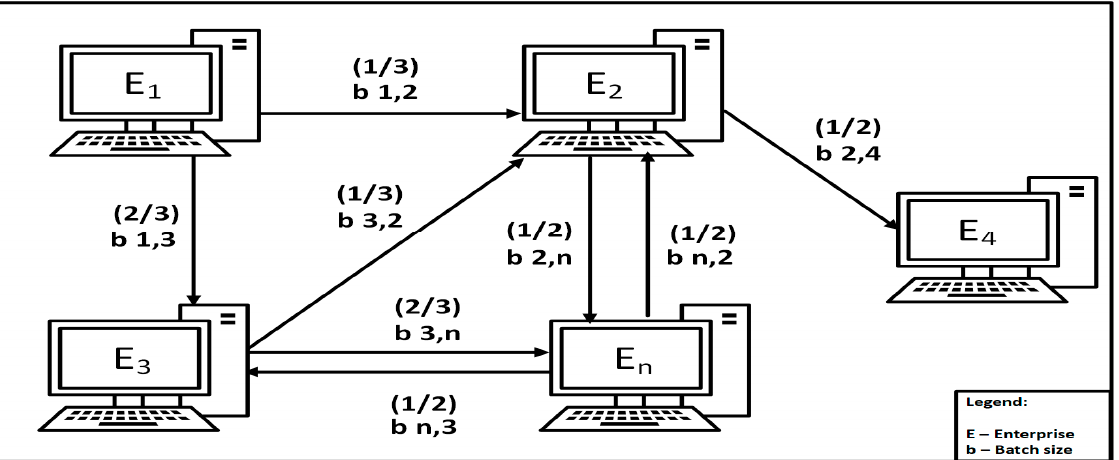
Figure 3. Generating orders to companies in the VE according to the highest competence rule using consortium blockchain.